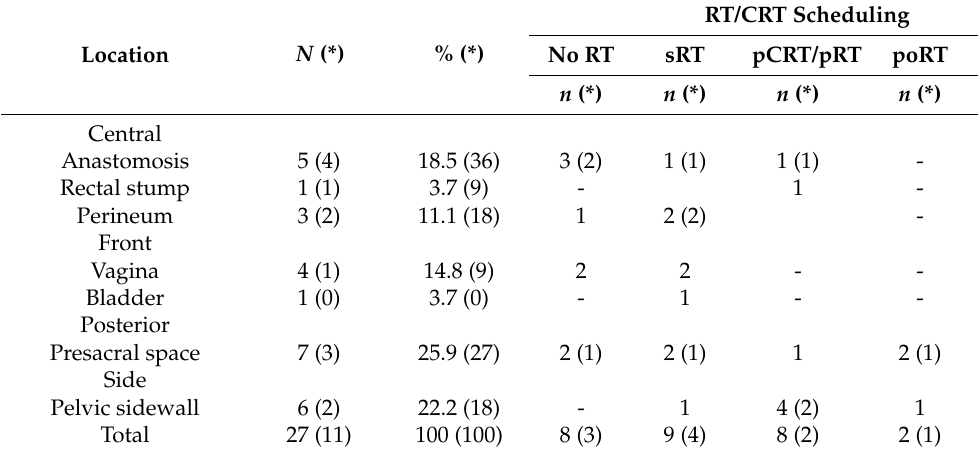
Table 4. Treatment for locally recurrent rectal cancer according to local recurrence